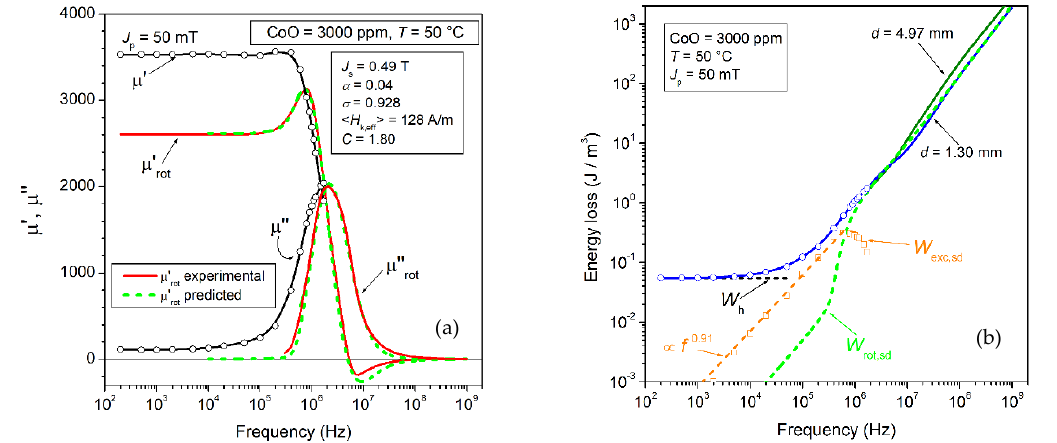
Figure 14. Decomposition of permeability and energy loss in a 4000 ppm CoO Mn-Zn ferrite. ( a ) The rotational permeability components μ ′ rot ( f ) and μ ″ rot ( f ) are extracted from the measured μ ′ ( f ) and μ ″ ( f ), according to the method discussed in Section 2.2. They are fully described in terms of μ ′ rot,sd ( f ) and μ ″ rot,sd ( f ), according to Equation (29). ( b ) The energy loss component W rot,sd ( f ), correspondingly calculated using Equation (13), equally fits the high-frequency losses in the thin ( d = 1.30 mm) eddy-current free samples. The excess loss is finally obtained by subtraction: W exc,sd ( f ) = W ( f ) − W h − W rot,sd ( f ). The power-law dependence on frequency W exc,sd ( f ) ∝ f 0.91 is predicted by Equation (32), with the parameter m =